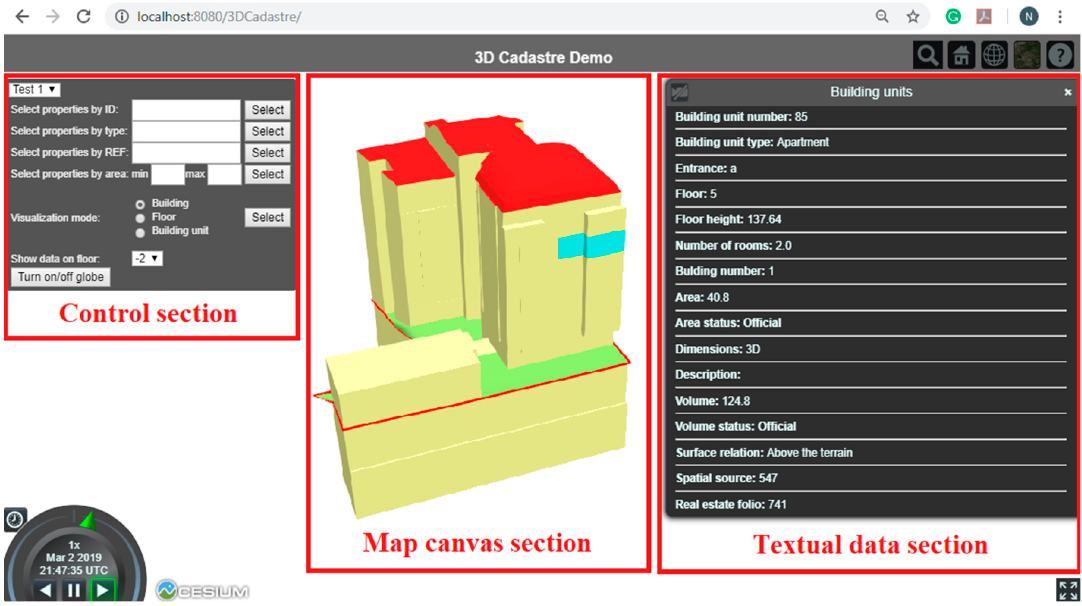
ISPRS Int. J. Geo-Inf. 2019 , 8 , x FOR PEER REVIEW Figure 8. User interface of the 3D cadastre application (available online: Figure 8. User interface of the 3D cadastre application (available online: http: // osgl.grf.bg.ac.rs / 3dcad / ).